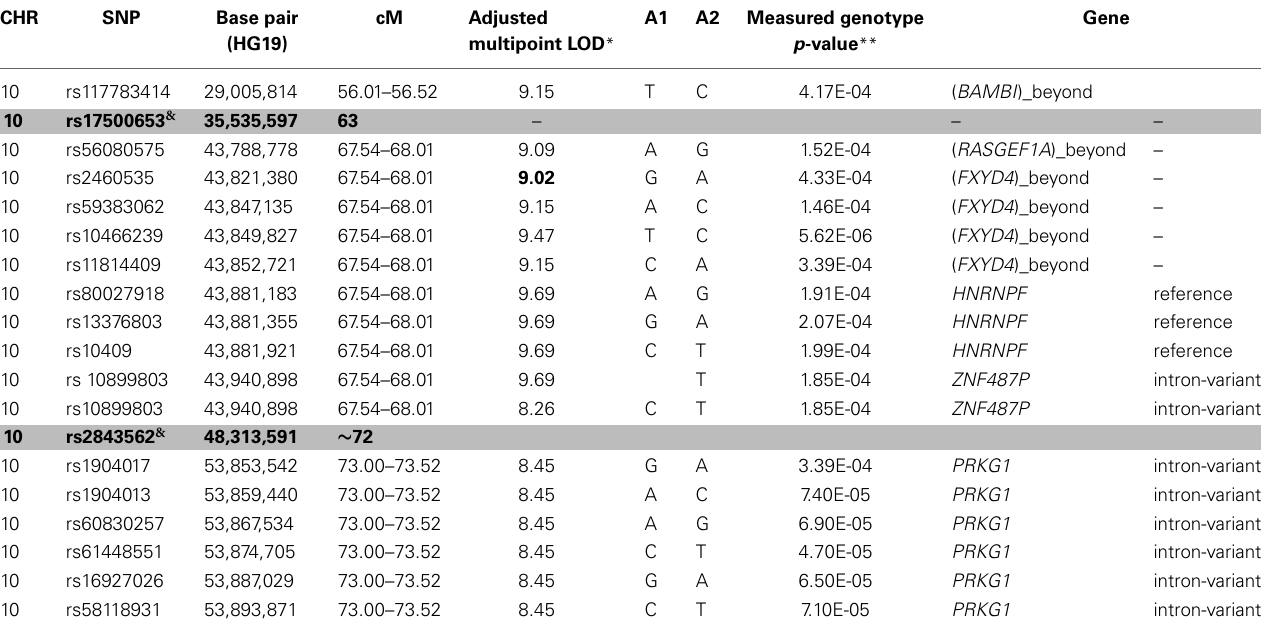
Table 5B | SNP association under the 10q11.21 linkage peak.